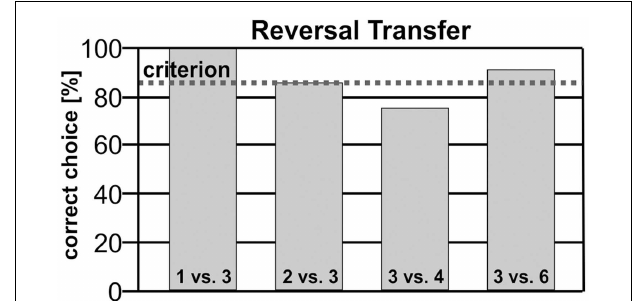
FIGURE 8 | Blue’s performance for the reversal contingencies 1 vs. 3, 2 vs. 3, 3 vs. 4, and 3 vs. 6. Only for the stimuli pair 3 vs. 4 did Blue’s performance not reach criterion (75%), albeit his acquisition clearly was above chance